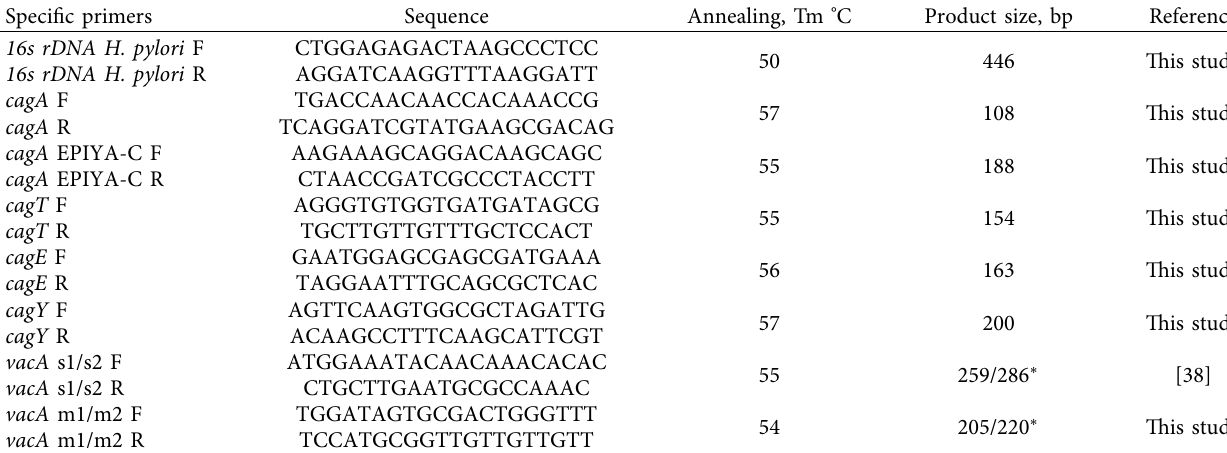
Table 1: Primers of H. pylori T4SS, 16s rDNA , and vacA in simple PCR.